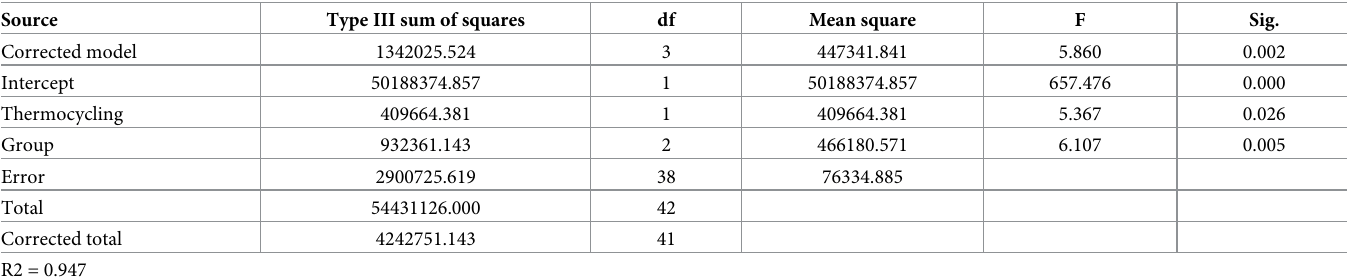
Table 2. Statistical results of the two-way ANOVA